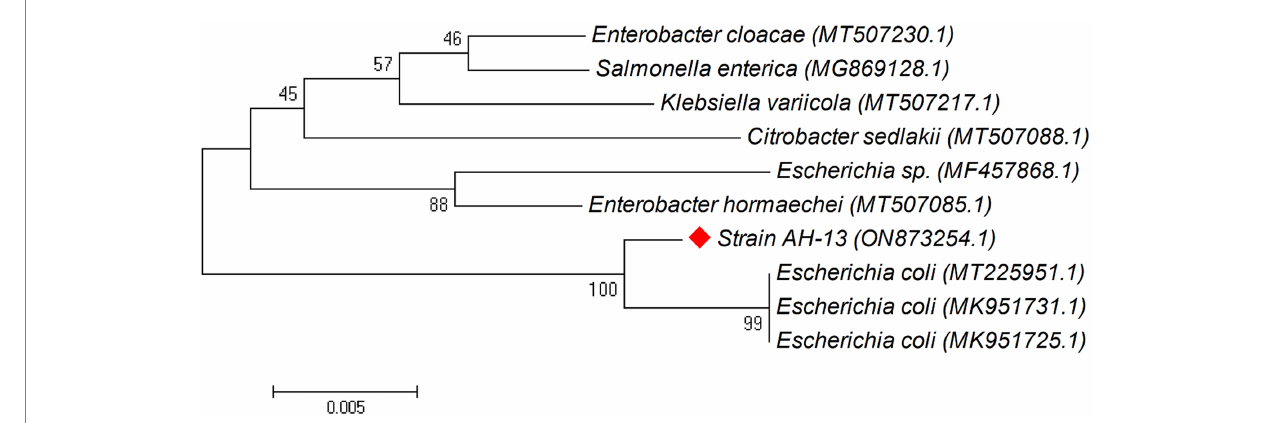
FIGURE 4 Phylogenetic relationship between the strain AH-13 and other 16S rRNA gene sequences of published strains. In the phylogenetic tree, AH-13 and Escherichia coli were clustered together as one clade. The scale bar corresponds to a 0.005 nucleotide substitution per sequence position. The number in parentheses represents the accession number in GenBank.